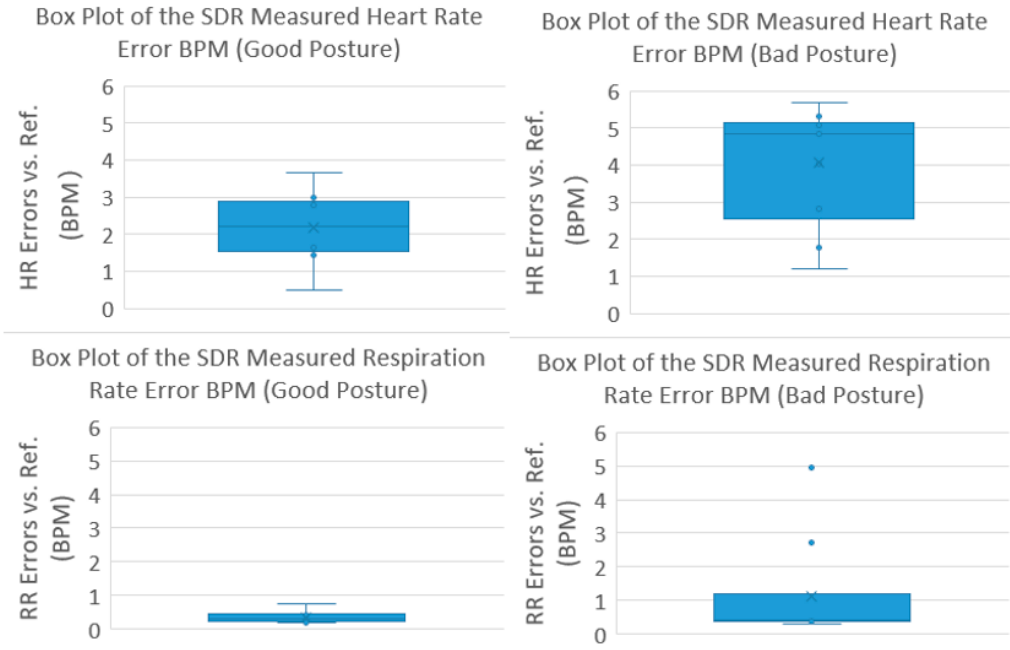
Figure 7. Analysis of output data of 10 cases of student volunteers with “Bad posture” vs. “Good posture”.